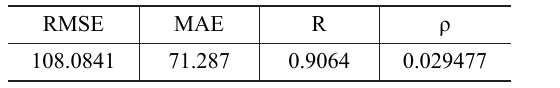
Table 4. Errors and